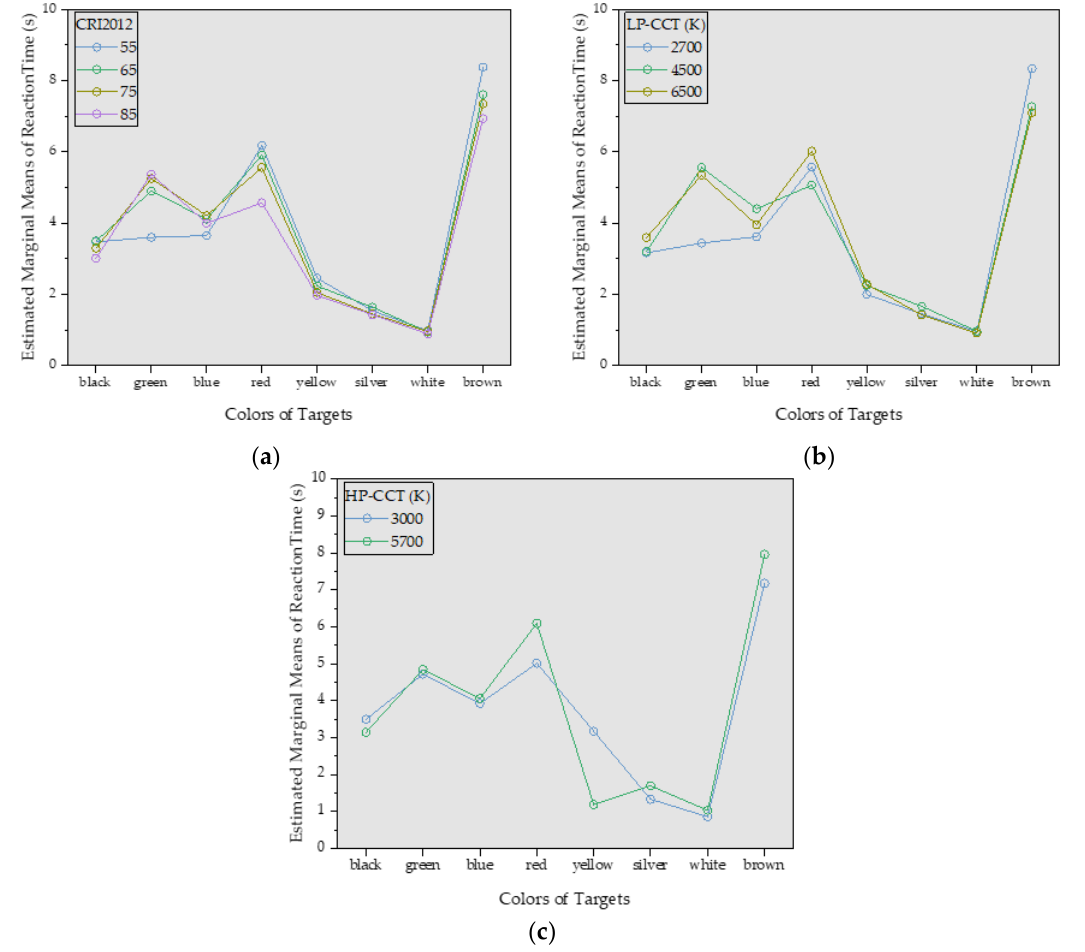
Figure 19. The simple effect analysis of three groups of significant interactions. ( a ) CRI2012 × Color. ( b ) Color × LP-CCT. ( c ) Color × HP-CCT. ( b ) Color × LP-CCT. ( c ) Color ×